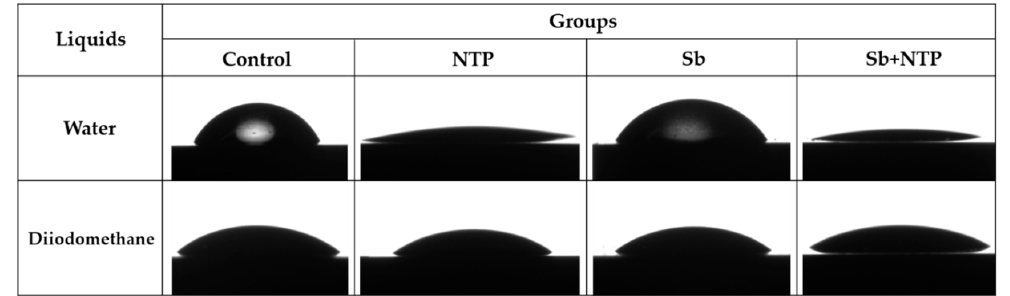
Figure 5. Images of contact angles of water and diiodomethane droplets on different Y-TZP surface treatments. Control, no treatment; NTP, non-thermal atmospheric pressure plasma; Sb, sandblasting; Sb + NTP, sandblasting followed by non-thermal atmospheric pressure plasma.